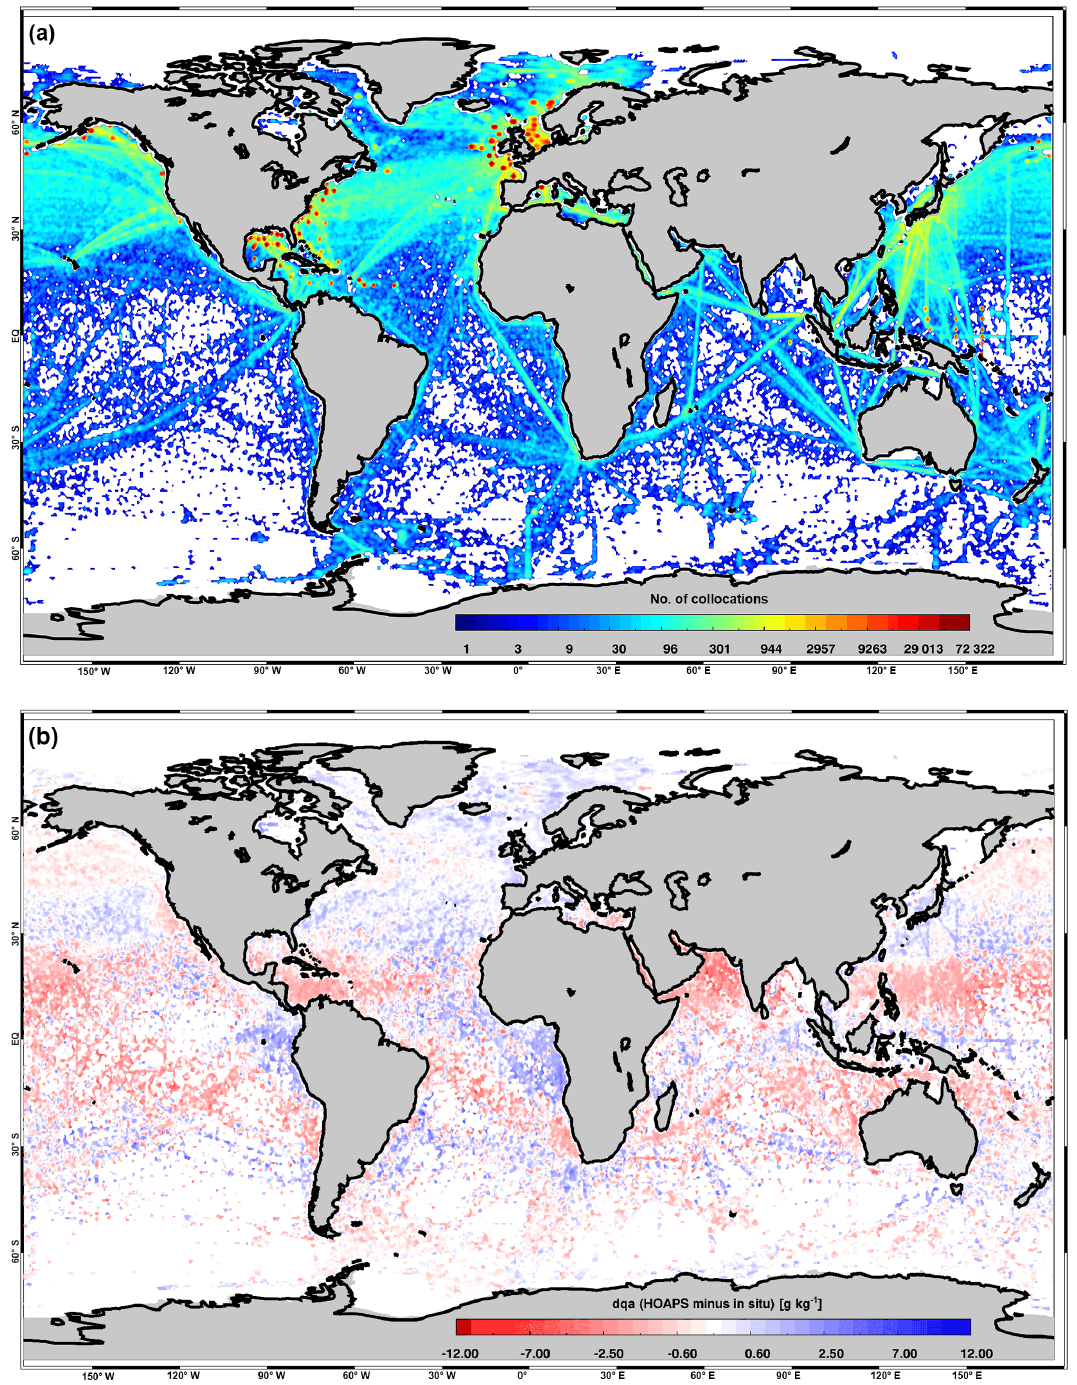
Figure 1. (a) Global map showing the distribution of collocated q a measurements (HOAPS vs. high-quality in situ) between 2001 and 2008. Overall, more than 13.8 million matchups contribute to this density map. Note that the colour bar is logarithmic. (b) Two-dimensional illustration of the near-surface humidity biases d q a (HOAPS minus in situ, 2001–2008) shown in Fig. 2. Note that the colour bar is not